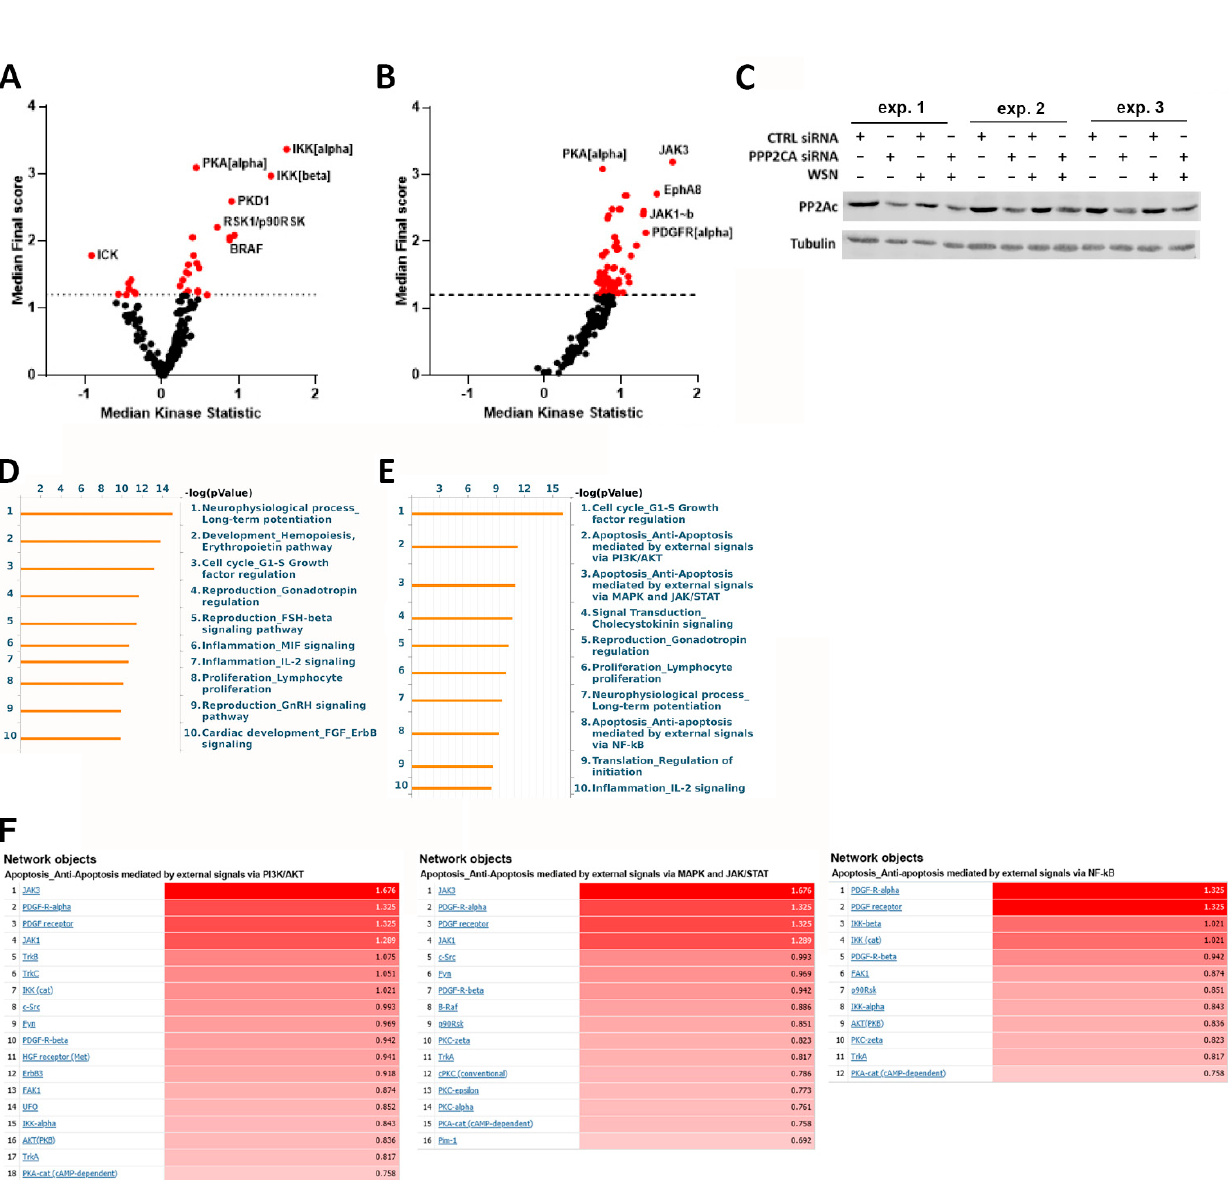
Figure 5. PP2A controls different signaling pathways decisive for cell survival in IAV infection. ( A – E ) A549 cells were mock-infected ( A ) or infected with WSN (MOI = 5) ( B ) 48 h after PP2Ac KD, and kinase activity was assessed 8 hpi by chip-based kinase activity profiling (PamGene technology). Differences in kinase activity in PP2Ac-silenced compared to CTRL siRNA-transfected cells are depicted as median kinase statistic (negative values = lower activity, positive values = higher activity) of three independent experiments. ( C ) Efficient PP2Ac KD in independent experiments was confirmed using Western blotting. ( D , E ) Network process enrichment analyses of differentially activated kinases obtained in mock-infected ( D ) or IAV-infected ( E ) cells were computed using MetaCore. ( F ) Lists of network objects of apoptotic processes and their differential activation.